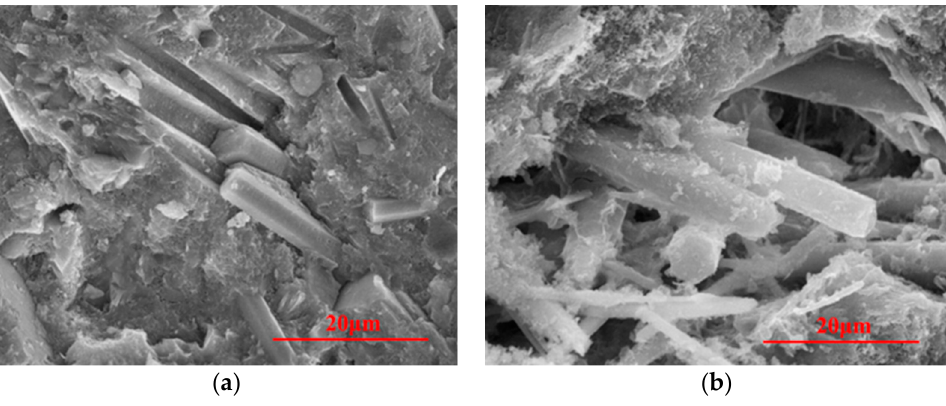
Figure 10. MSFRC at ( a ) Room temperature and ( b ) 600 ◦ C under